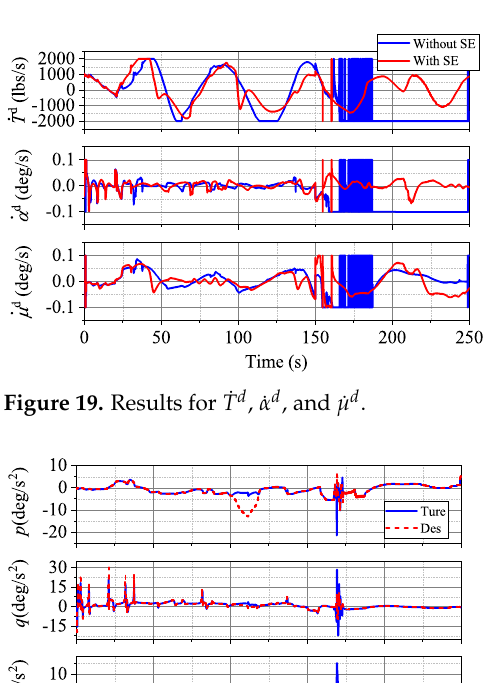
Figure 18. Results for α , β , and µ without SE.